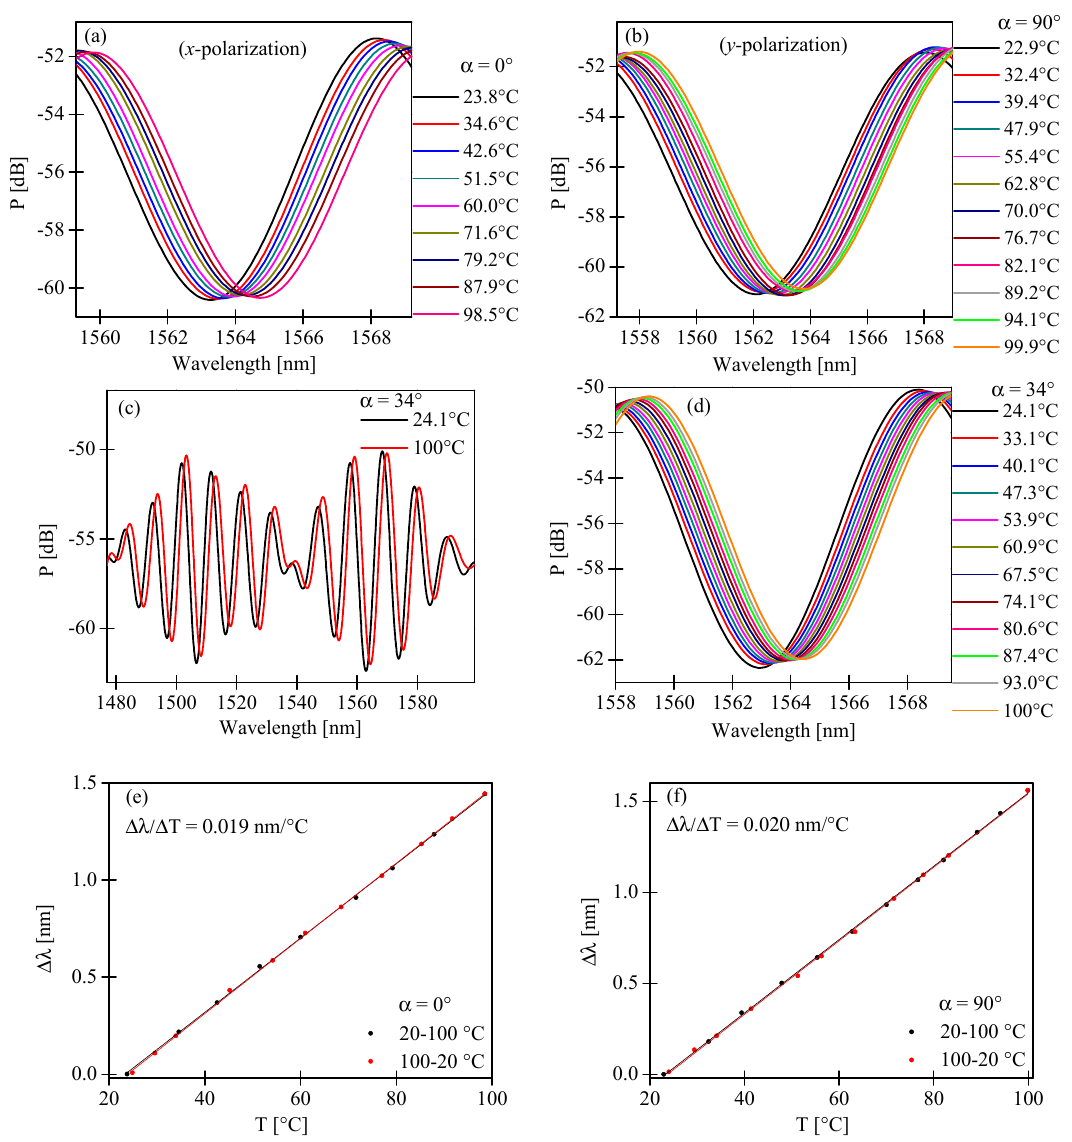
Figure 10. Displacement of the intermodal interference fringe with the intensity minimum close to 1563 nm for increasing temperature in the range of 20–100 °C and azimuth of the input polarization state set at α = 0° ( a ); α = 90° ( b ); and α = 34° ( d ). Output spectrograms registered for the lowest and the highest values of temperature showing the displacement of the envelope for α = 34° ( c ). Displacement of the intermodal interference fringe with an intensity minimum close to 1563 nm for increasing and decreasing temperature for the azimuth of the input polarization state set at α = 0° ( e ); and α = 90° ( f ).